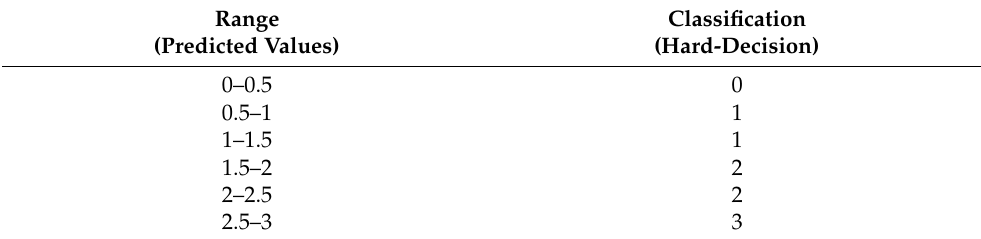
Table 6. Mapping table for classifying the results of convolutional neural network (CNN)-based